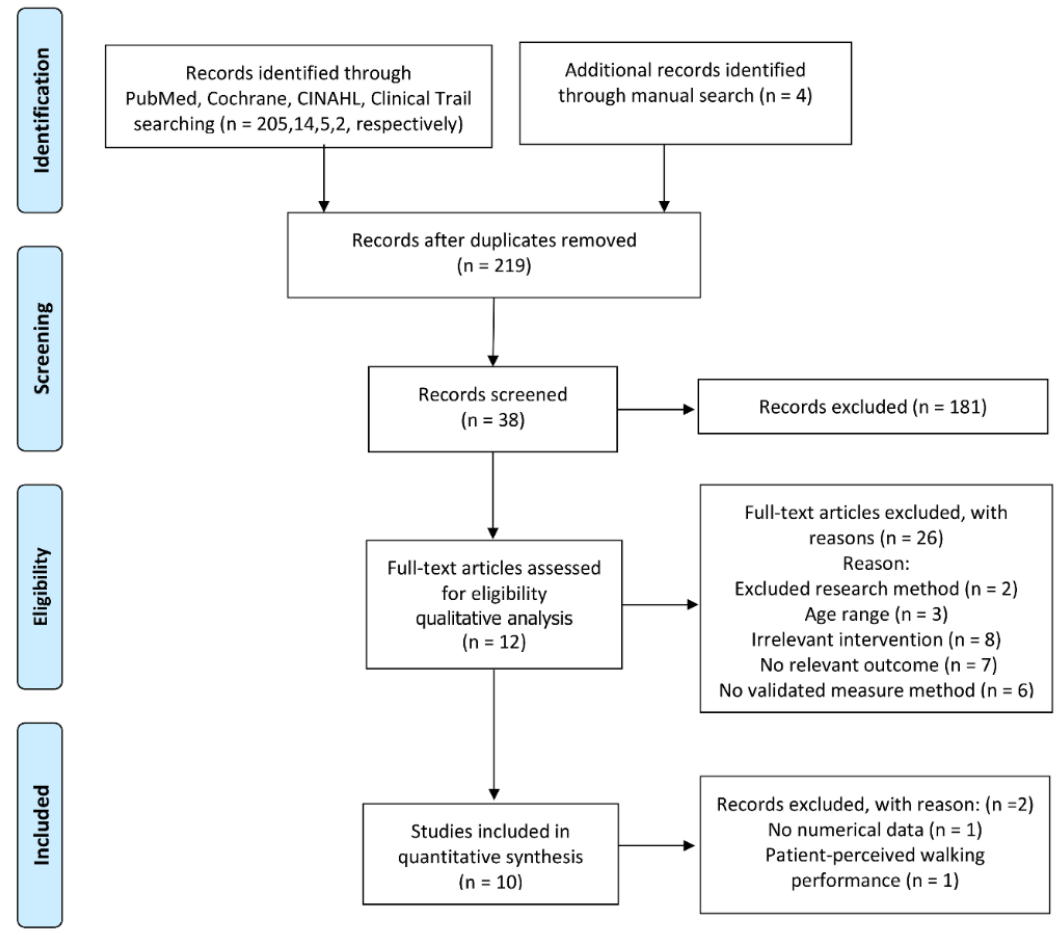
Figure 2. Flow chart of the study selection. Cumulative Index to Nursing and Allied Health Literature